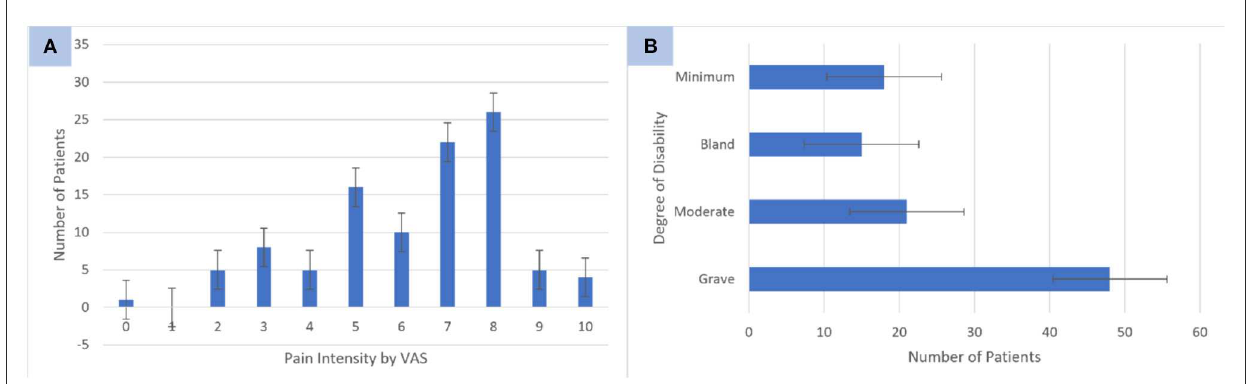
FIGURE2 (A) Pain intensity according to Visual Analog Pain Scale (VAS) scores in patients with headache and long-term COVID-19. (B) Degree of disability of patients with headache and long-term COVID-19. Source: research protocol. Standard error ≤